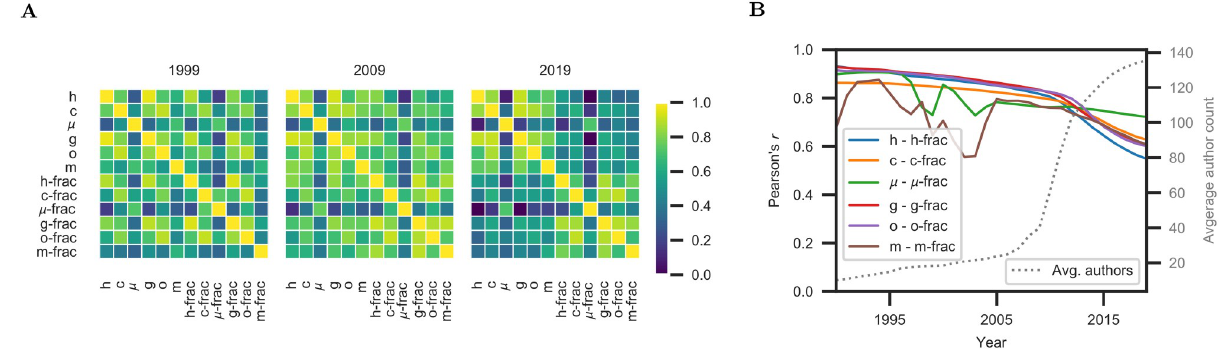
Fig 4. Correlation between scientometric measures. ( A ) Correlation matrices of scientometric measures in the years 1999, 2009, 2019. ( B ) Temporal evolution of correlations between traditional measures and their fractional counterparts.